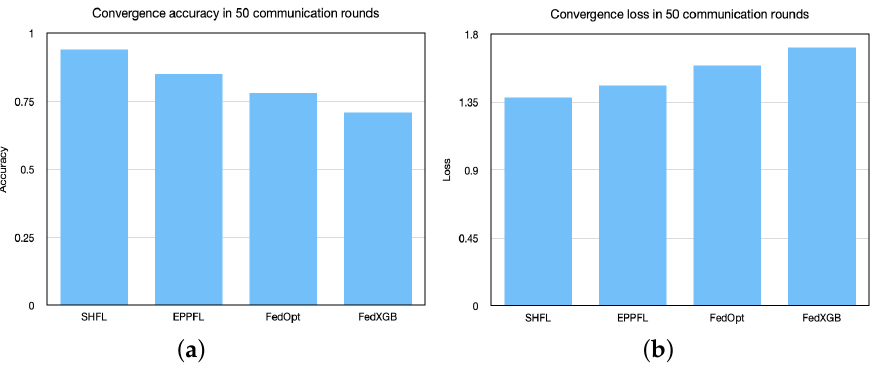
Figure 7. Convergence comparison of the proposed SHFL with state-of-the-art techniques, ( a ) comparison accuracy over MNIST; ( b ) comparison loss over